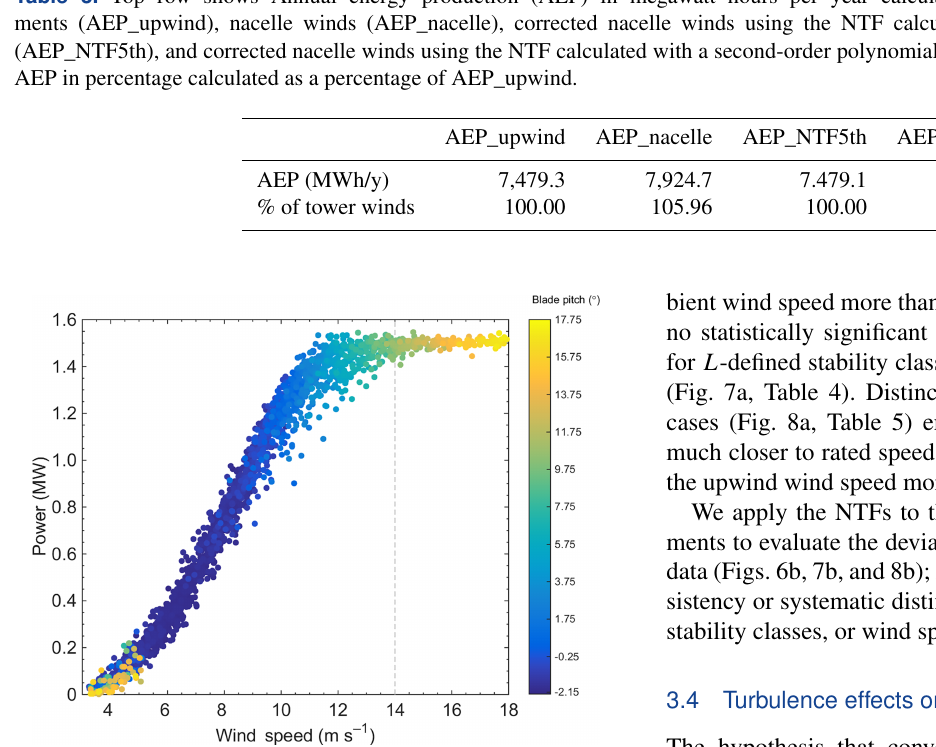
Figure 5. Scatter power curve using 80m tower winds after fil- tering for wind speeds between 3.5 and 25ms − 1 , wind directions between 235 and 315 ◦ , and for normal turbine operation. Colors of the scatter points correspond to blade pitch angles. The dashed gray line marks rated